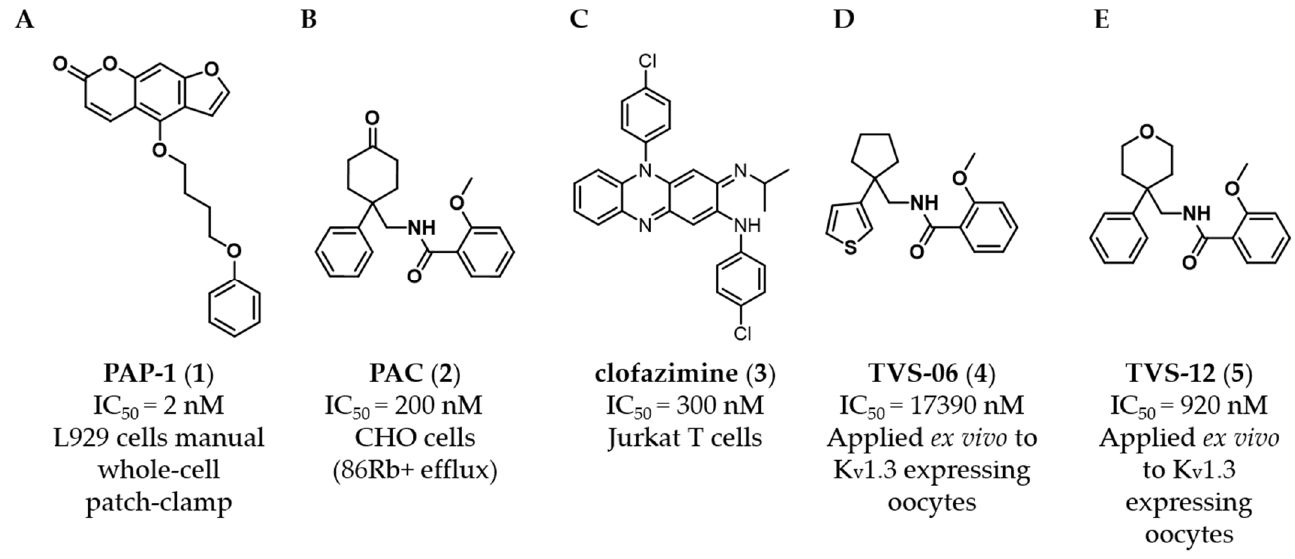
Figure 1. Structures of known representative K V 1.3 inhibitors. ( A ) PAP-1 ( 1 ). ( B ) PAC ( 2 ). ( C ) Clofazimine ( 3 ) ( D ) TVS-06 ( 4 ). ( E ) TVS-12 ( 5 ).